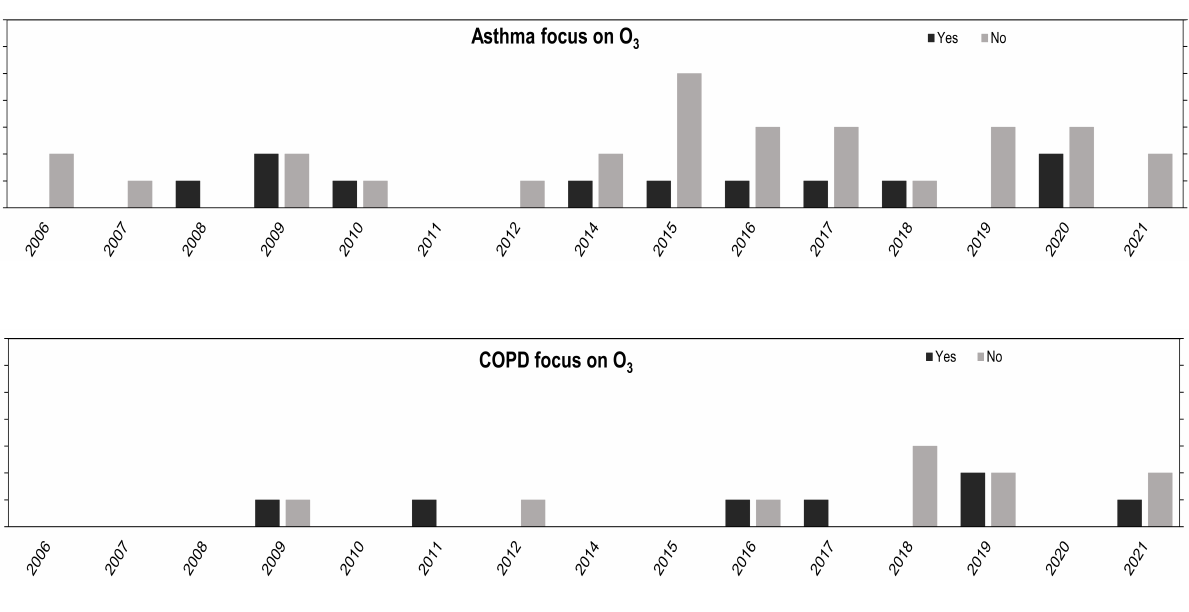
Figure 3. Number of publications over the years concerning ( a ) asthma and ( b ) COPD that have their focus on O 3 (Yes) or that focus on other air pollutants besides O 3